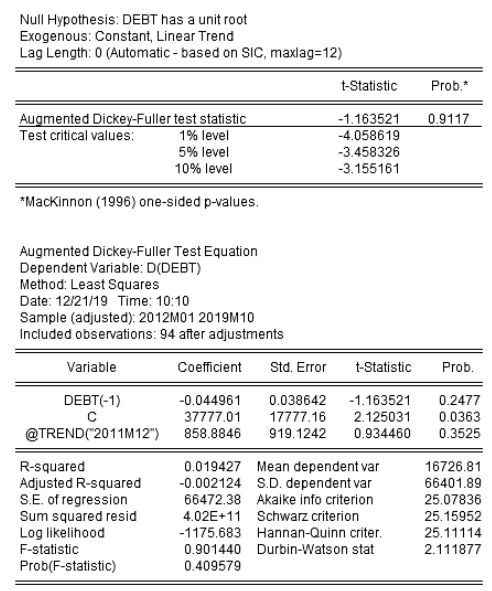
Figure 3. The results of the time series check in the first differences for